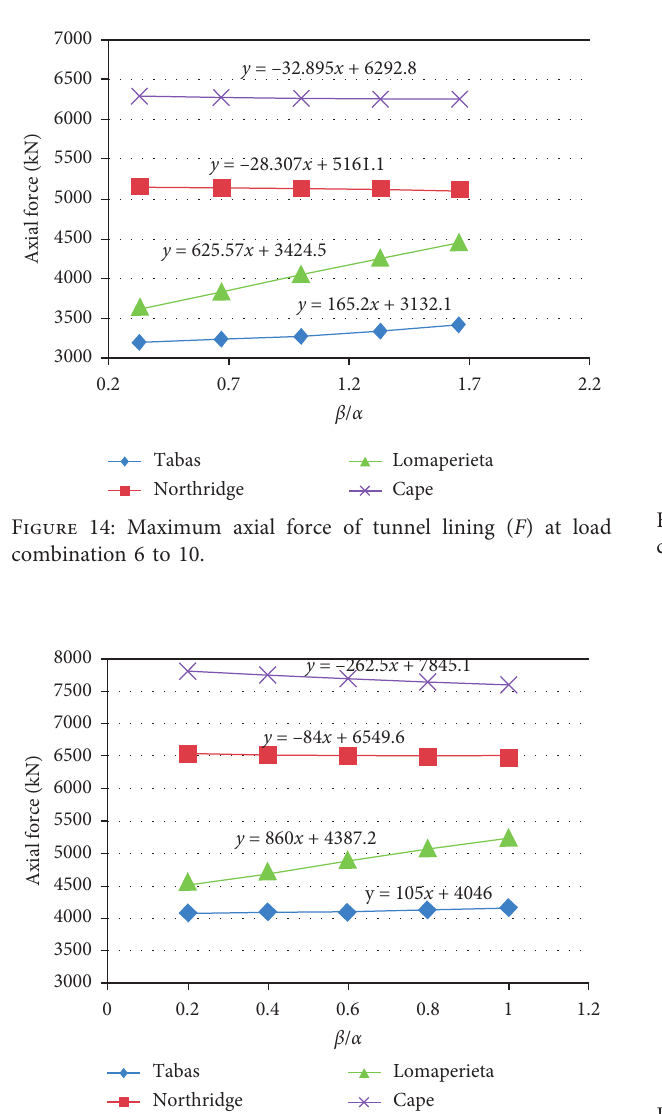
Figure 15: The maximum axial force of tunnel lining ( F ) at load combination 11 to 15.